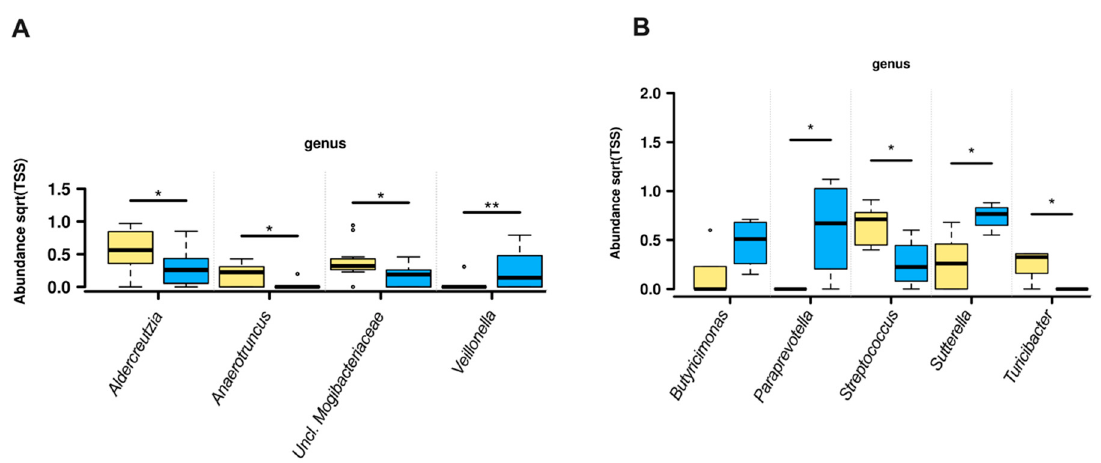
Figure 2. Comparison of genus abundance in women with future HDP at 28 weeks gestation with low and high fiber intake. ( A ) Genus abundance with fiber intake below (lower fiber; yellow boxes) or above (higher fiber; blue boxes) the median (18.2 g / day). ( B ) Genus abundance with fiber intake in the lowest (Q1; < 13.9 g / day; yellow boxes) and highest (Q4; > 23.1 g / day; blue boxes) of fiber intake. * = p < 0.05, ** = p < 0.01.